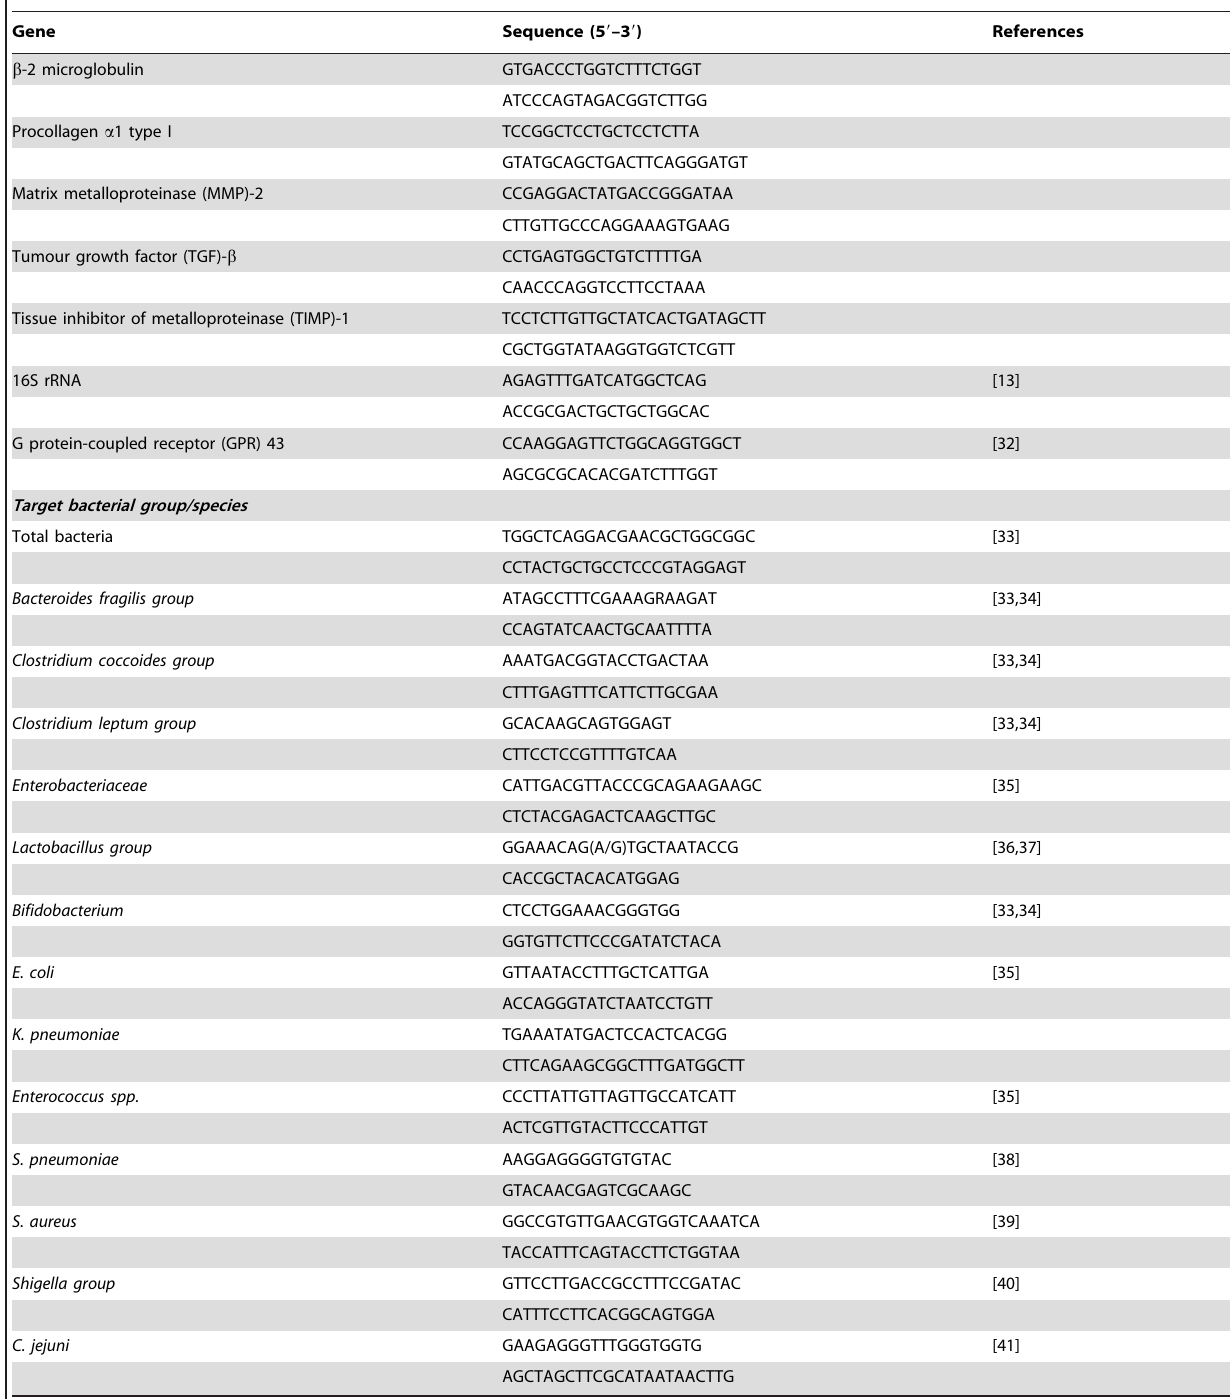
Table 4. List of primer pairs used in the